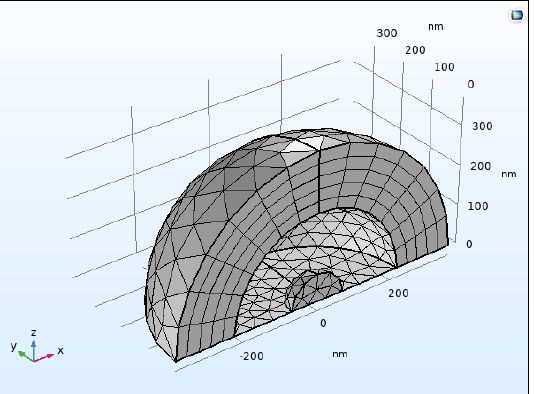
Figure 3. Screenshot of 3D meshing creation of uranium nanoparticle of 40 nm size from COMSOL. The Scattering Boundary Condition was determined at the exterior boundary of the PML . The “ Wave Equation, Electric ” physics are supplemented under the “ Electromagnetic Waves, Frequency Domain (emw) ” interface. Following the research, Parametric Sweep was introduced from 300 nm to 800 nm, with a step size of 10 nm.